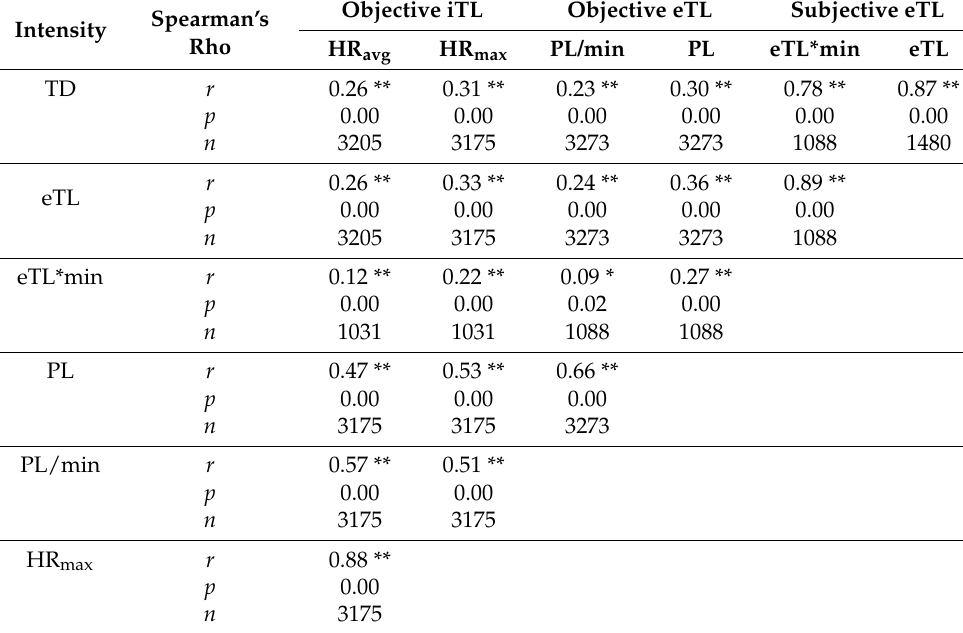
Table 4. Correlation analysis between the intensities recorded when applying the programs.